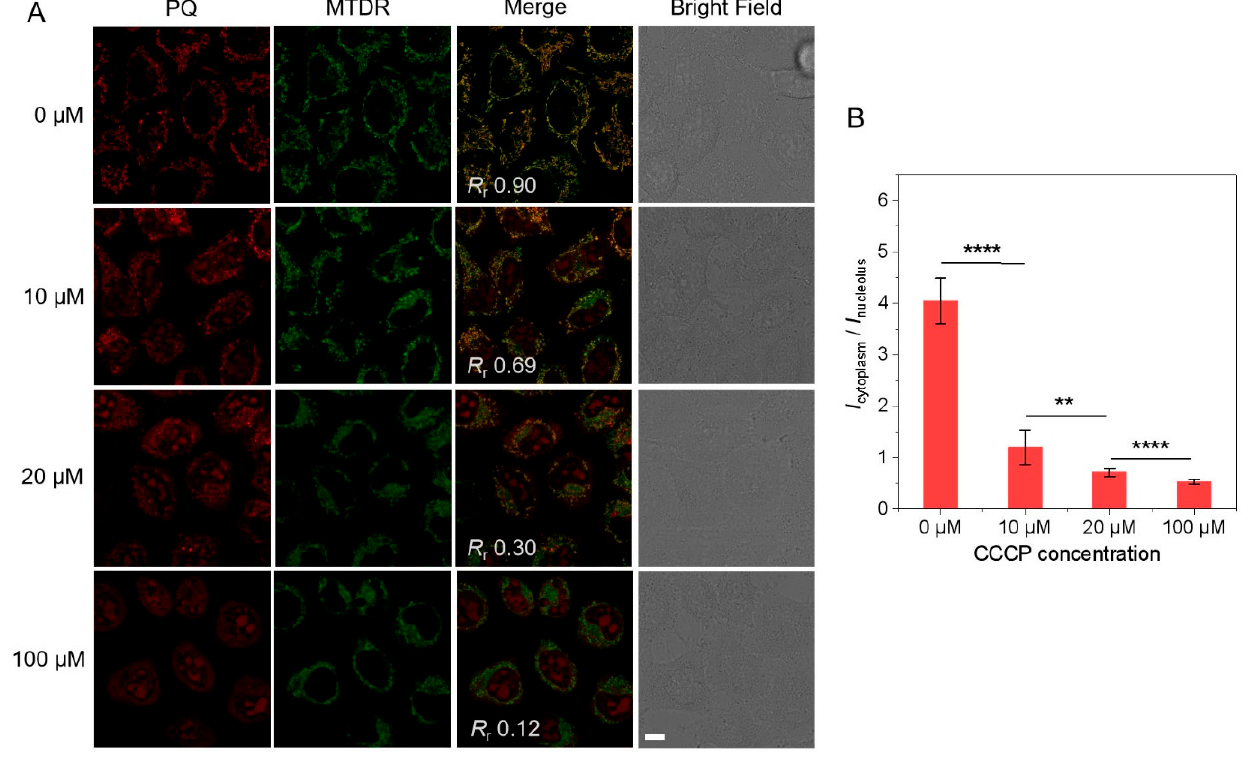
Figure 2. CLSM images of PQ in HeLa cells with decreasing MMP. ( A ) Colocalization images of live HeLa cells co-stained with PQ and MTDR after treatment with different concentrations of CCCP (0, 10, 20, 100 µM) for 10 min ( λ ex / λ em = 488 nm/550–650 nm for PQ , λ ex / λ em = 638 nm/660–750 nm for MTDR, scale bar: 10 µm) and ( B ) Corresponding ratios of relative fluorescence intensities in the cytoplasm and nucleolus ( I cytoplasm / I nucleolus ). [Mean ± SD (n = 50); **, p < 0.01; ****, p < 0.0001; Student’s t -test].